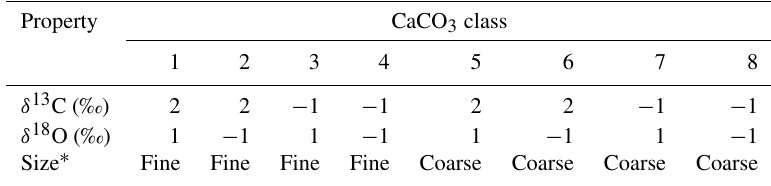
Table 4. Properties of CaCO 3 classes for simulations in Sect. 3.2.3. Property